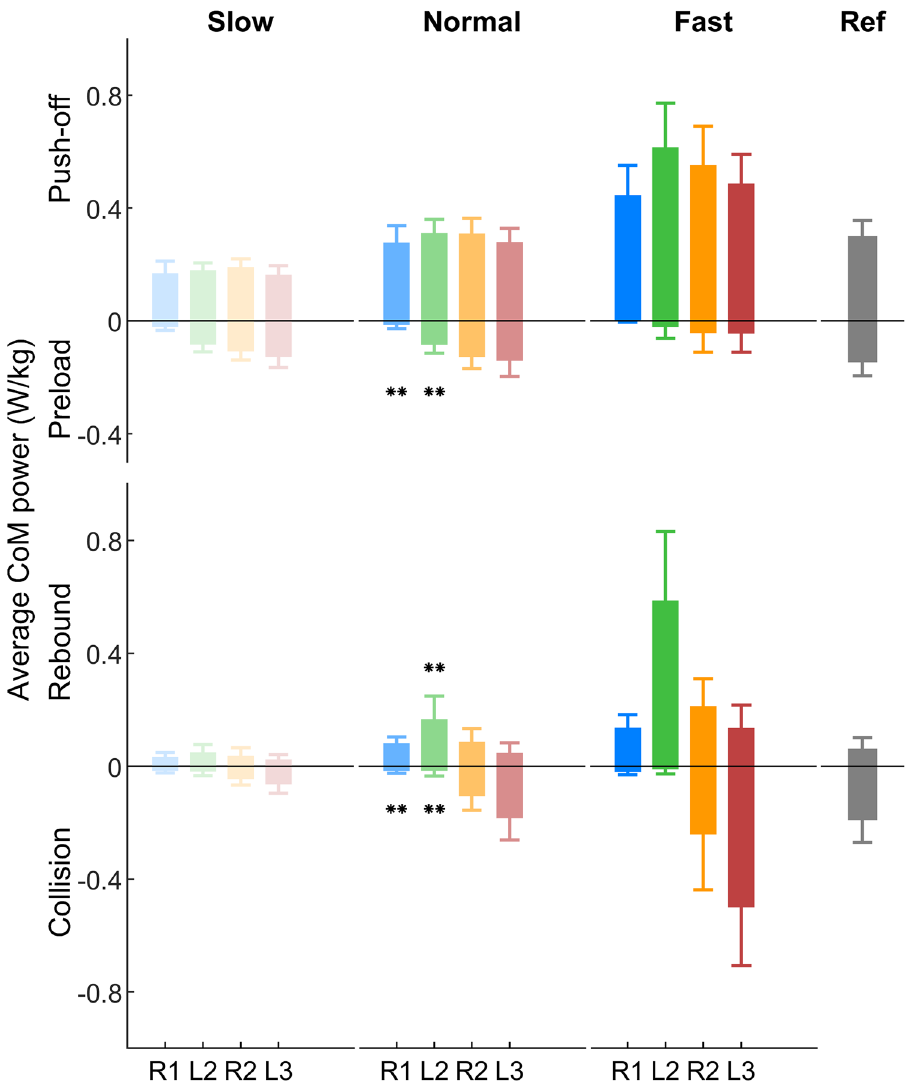
Figure 8. The average CoM power for slow, normal and fast gait initiation in the collision, rebound, preload and push-off phases. Error bars indicate standard deviation. L2 and L3 denote the second and third stride on the left side, respectively. R1 and R2 denote the first and second stride on the right side, respectively. Due to the low magnitude, the phase specific CoM mechanical power during L1 (the first left side stride) is not presented. The single asterisk (*) and double asterisks (**) indicate a significant difference at p < 0.05 and p < 0.01 with respect to Ref, respectively. Detailed statistical analysis results can be found in Supplementary Table